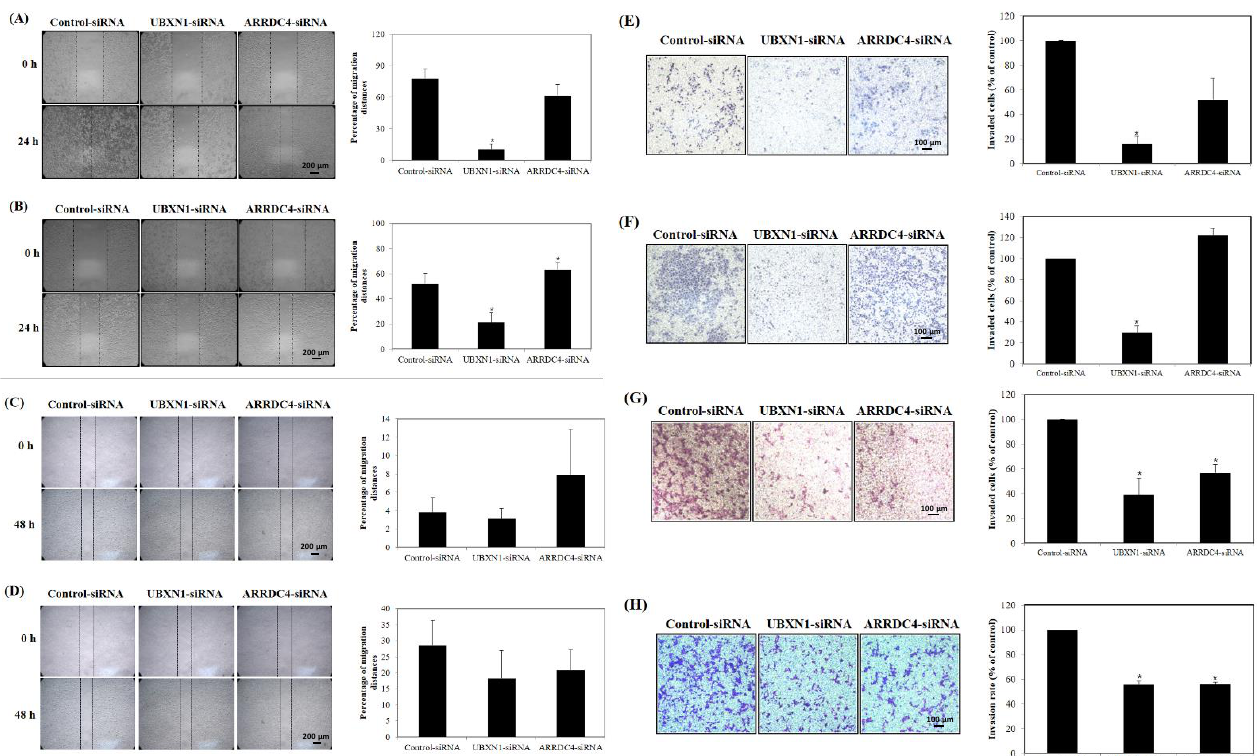
Figure 4. Knockdown of UBXN1 and ARRDC4 inhibits prostate cancer cell migration in PC3 ( A ), DU145 ( B ), LNCaP ( C ), and 22Rv1 cells ( D ) and invasion PC3 ( E ), DU145 ( F ), LNCaP ( G ) and 22Rv1 cells ( H ). Each cells were transfected with siRNA-targeted UBXN1 and ARRDC4 or its negative control. Cell migration and invasion were measured by wound-healing assay. Data are the average of at least three independent experiments. * p < 0.05 compared to negative control. Scale bar: XXX